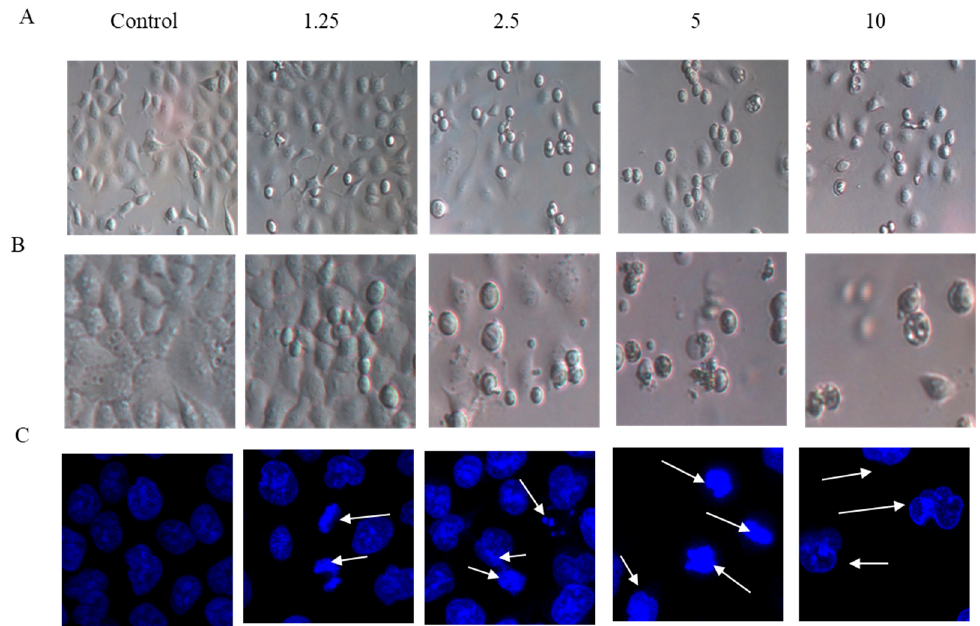
Figure 3. Morphological changes of CNE-2 induced by arnicolide D. CNE-2 cells were treated with different concentrations of arnicolide D (2.5–10 μ M) for ( A ) 24 h or ( B ) 48 h and cell morphology was observed under an optical microscope (magnification, 100×). ( C ) After 48 h treatment, cells were stained with DAPI and their nuclear morphologies were observed using confocal microscopy (magnification, 400×).